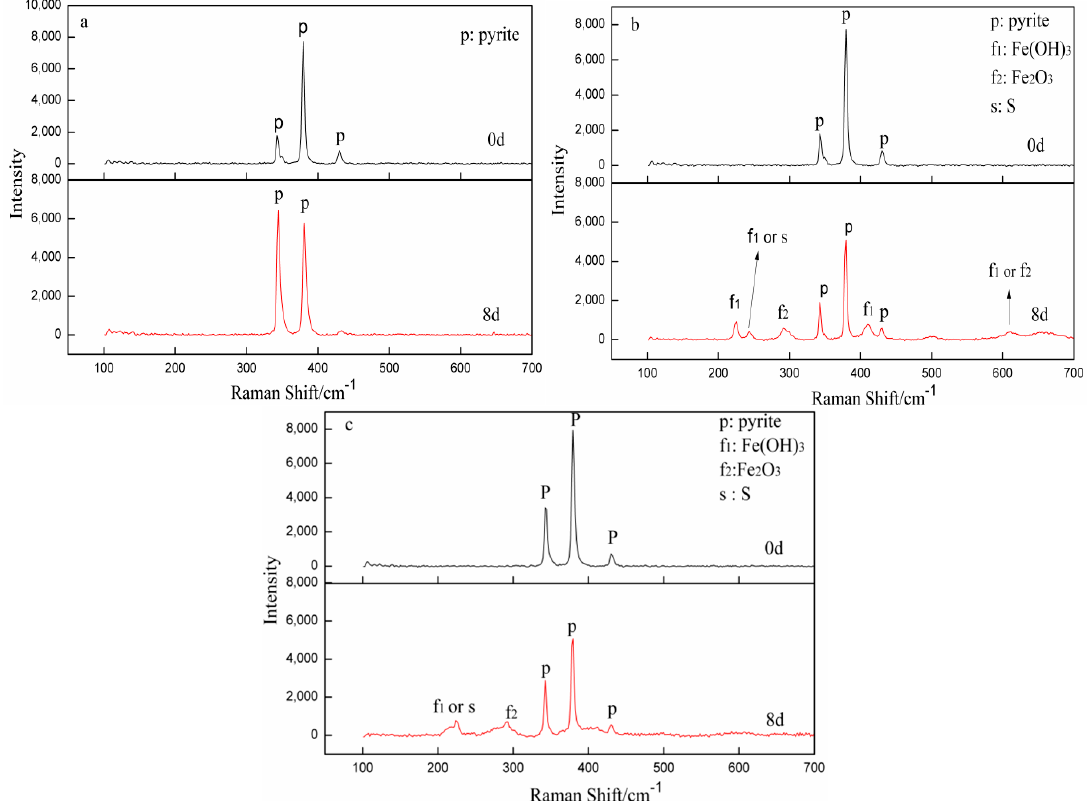
Figure 6. Raman spectrum on the crystal directions of pyrite: ( a ) (100); ( b ) (110), and ( c ) (111).